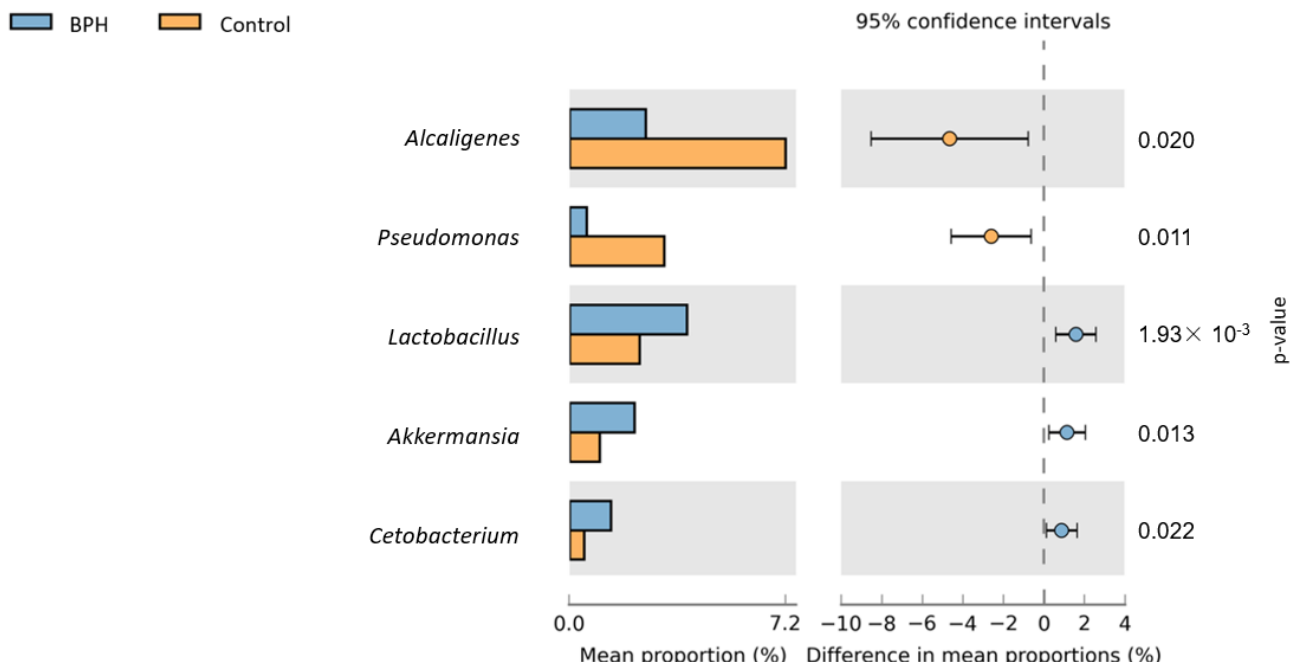
Figure 6. Urine sample microorganism genus relative abundance—BPH vs. Control. Left side of the figure shows mean abundance proportion. Right side shows difference in mean abundance proportions 95% confidence interval.